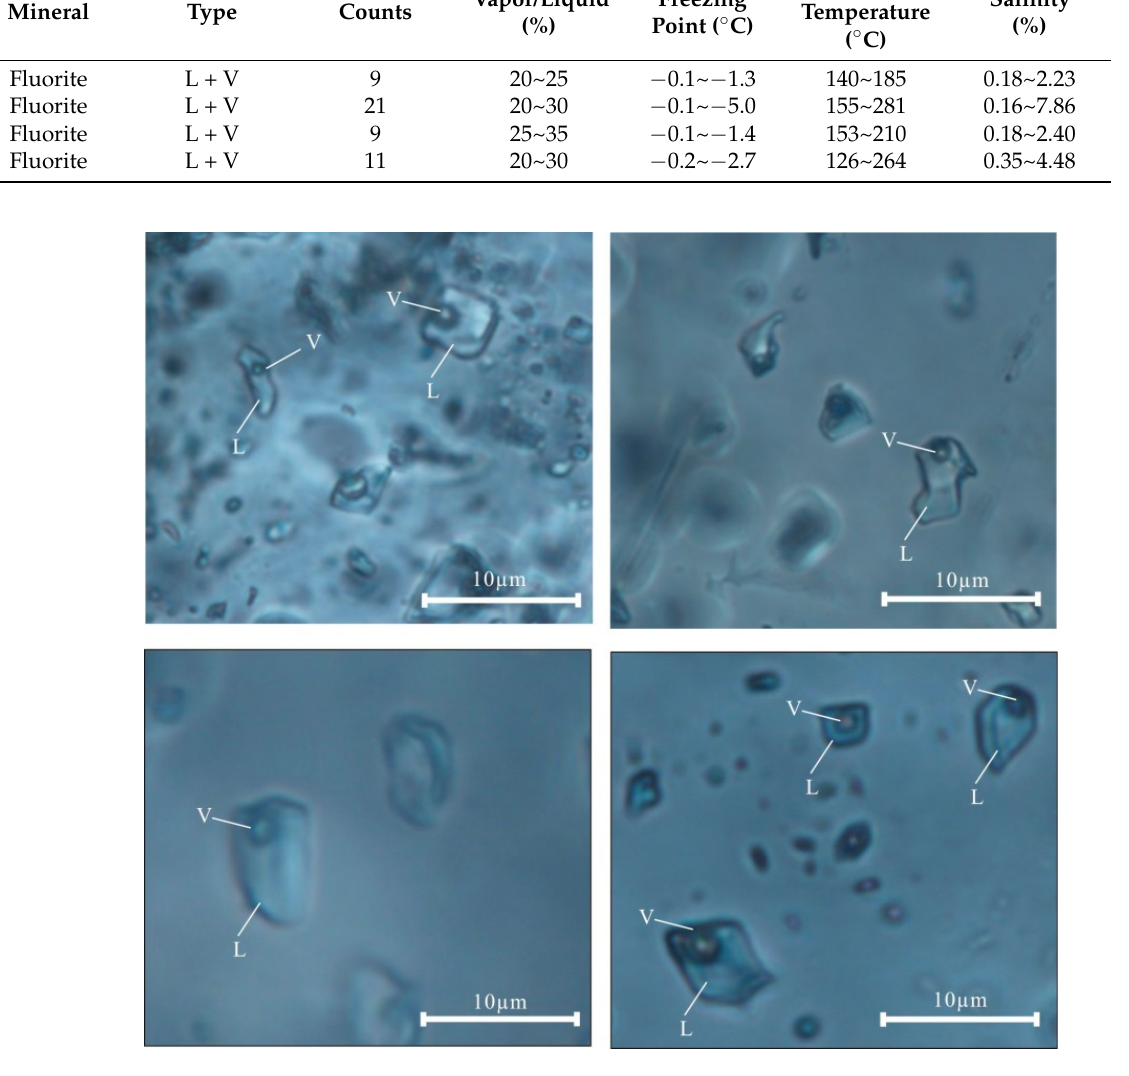
Figure 8. Photomicrographs of primary fluid inclusions in fluorite of the Shuanghuajiang fluorite deposit. L for liquid phase and V for vapor phase.